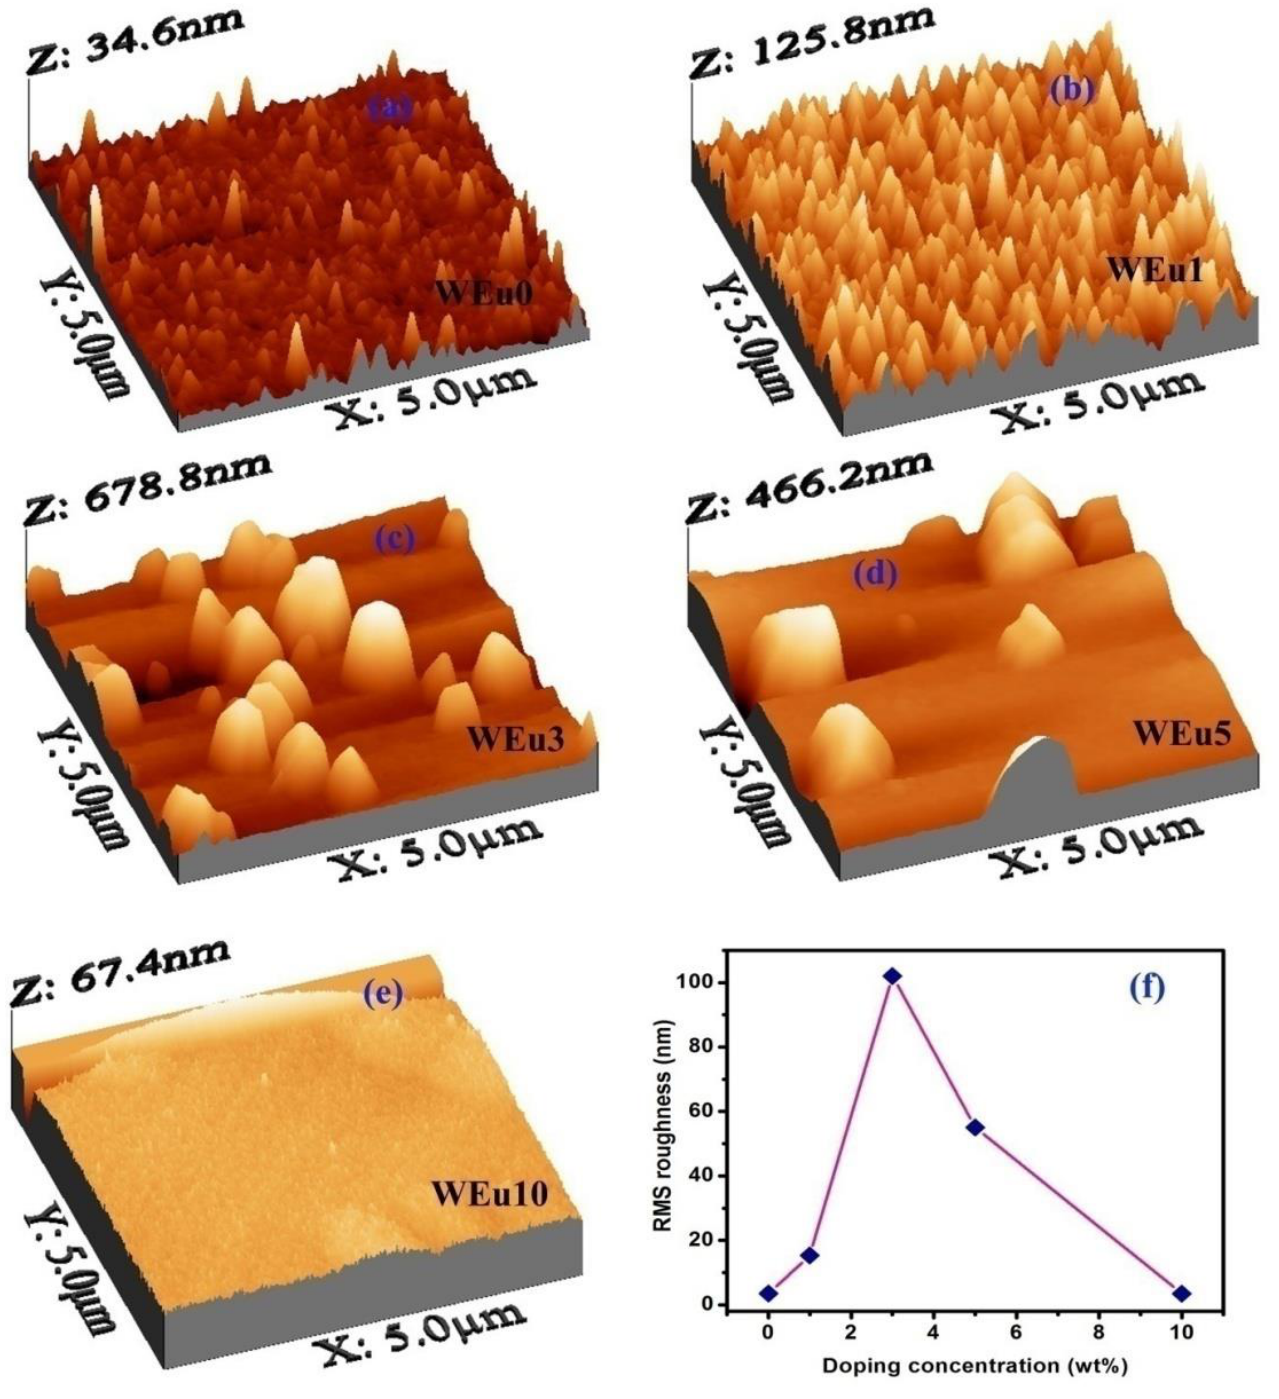
Figure 5. ( a – e ) Three-dimensional AFM images of the un-doped and Eu 3+ -embedded WO 3 films annealed at a temperature of 600 ◦ C; ( f ) variation of RMS surface roughness with respect to Eu 3+ -doping concentration.